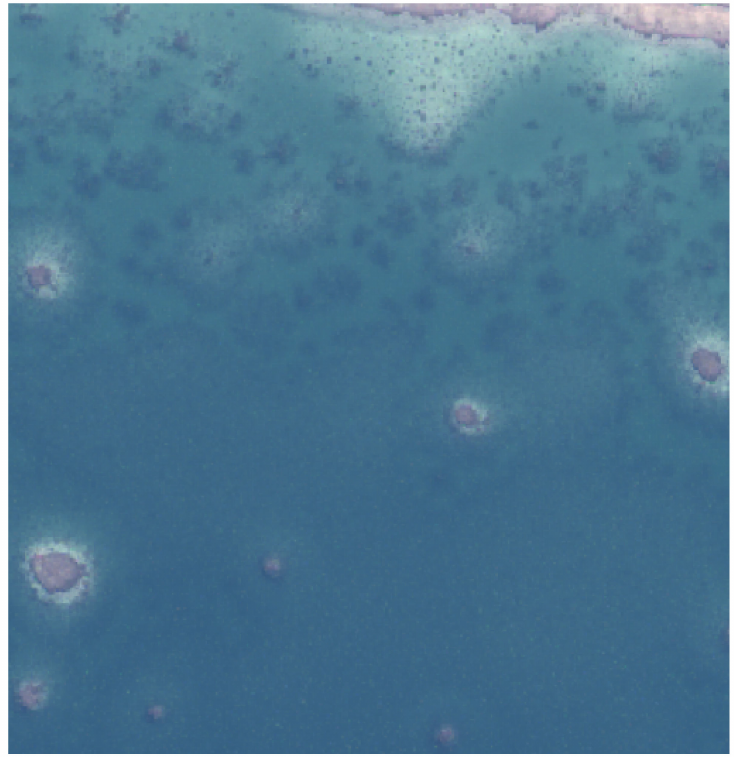
Figure 24. Example of a cloud of deep green-blue samples mixed with a trained multispectral